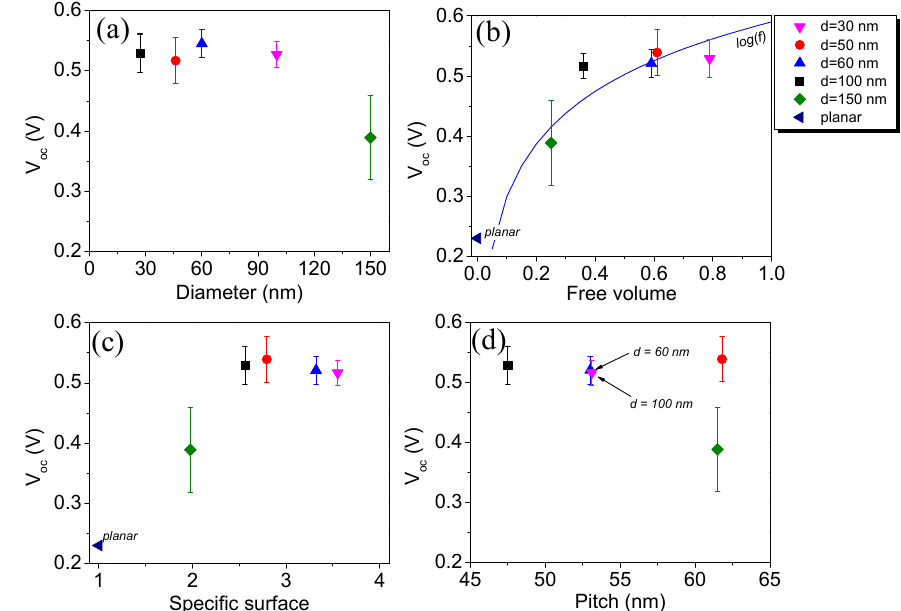
Figure 6. Open circuit voltage variation of Si / GaN NW / P3HT:PC 71 BM ordered heterostructures as a function of GaN NW morphological parameters: ( a ) average diameter; ( b ) free volume—log(f) plot is shown for comparison; ( c ) specific surface; ( d ) pitch. Color online.